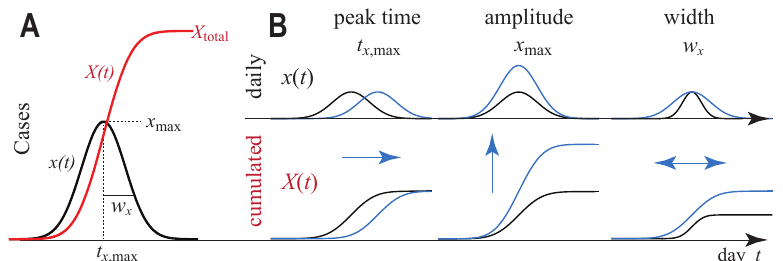
Figure 1. ( A ) Gauss model (GM) for time evolution of a daily quantity x ( t ) (black) and the corresponding total quantity X ( t ) (red), which is the cumulative sum of x ( t ) until time t . ( B ) Consequences of varying the three parameters describing the GM: width w x , maximum height x max , and time of maximum height t max for both the daily (top) and total (bottom) rates. In this work, x stands for either deaths ( x = d ) or confirmed infections ( x = i ).